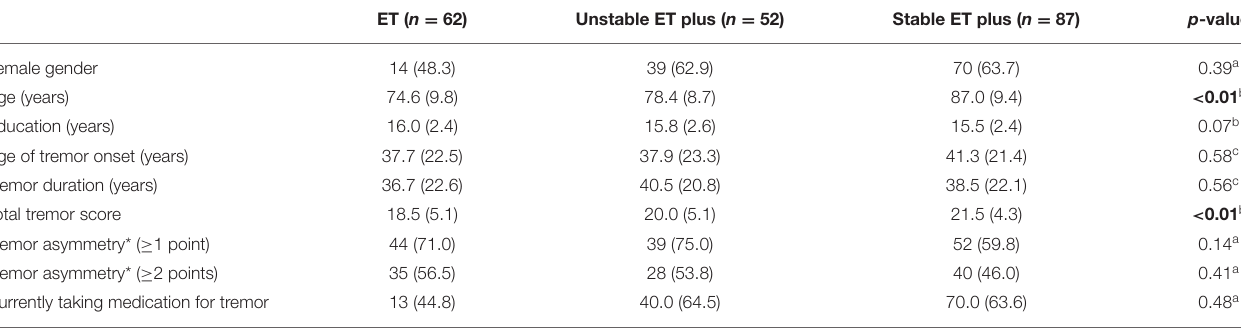
TABLE 2 | Comparison of baseline demographic characteristics across three “diagnostic behavior over time” categories.